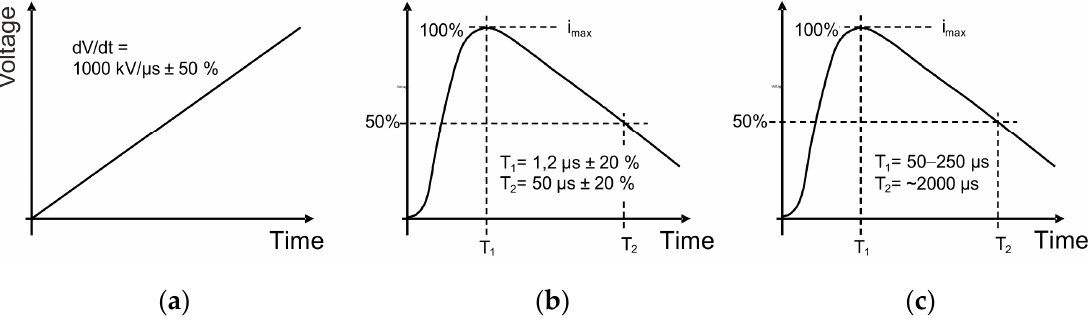
Figure 3. ( a ) Voltage waveform A, ( b ) voltage waveform B, and ( c ) voltage waveform D, adopted from reference